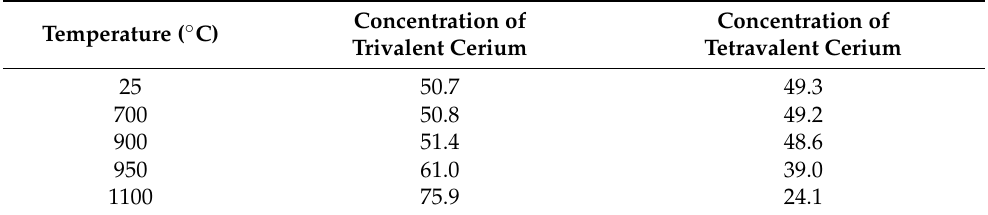
Table 3. Concentration of tri- and tetravalent cerium in the heating samples, based on the X-ray absorption near-edge structure analysis of the cerium L III edge